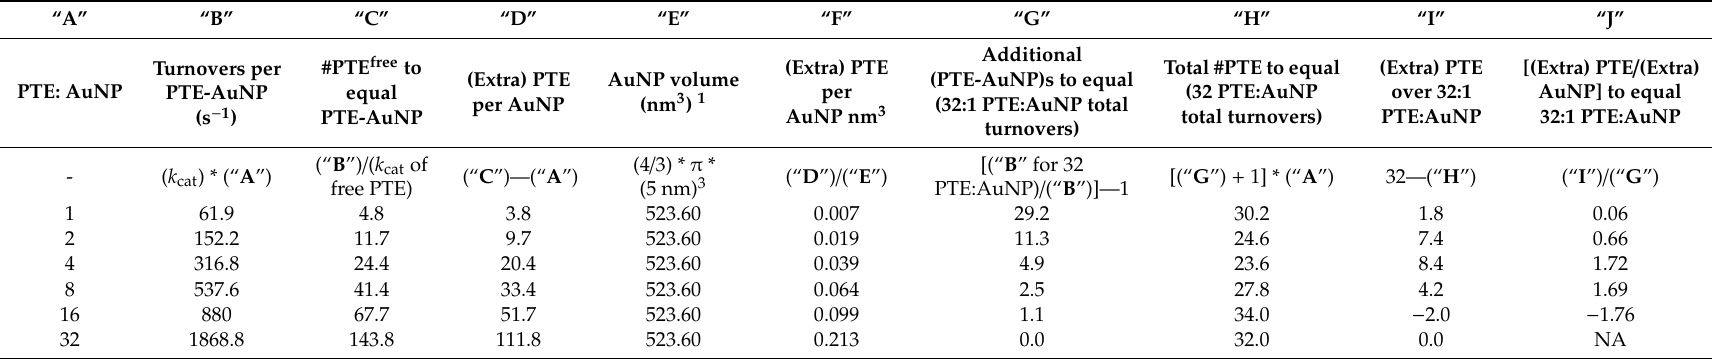
Table A1. Analysis of averaged enzyme activities for fixed NP diameter format on 10 nm AuNPs.